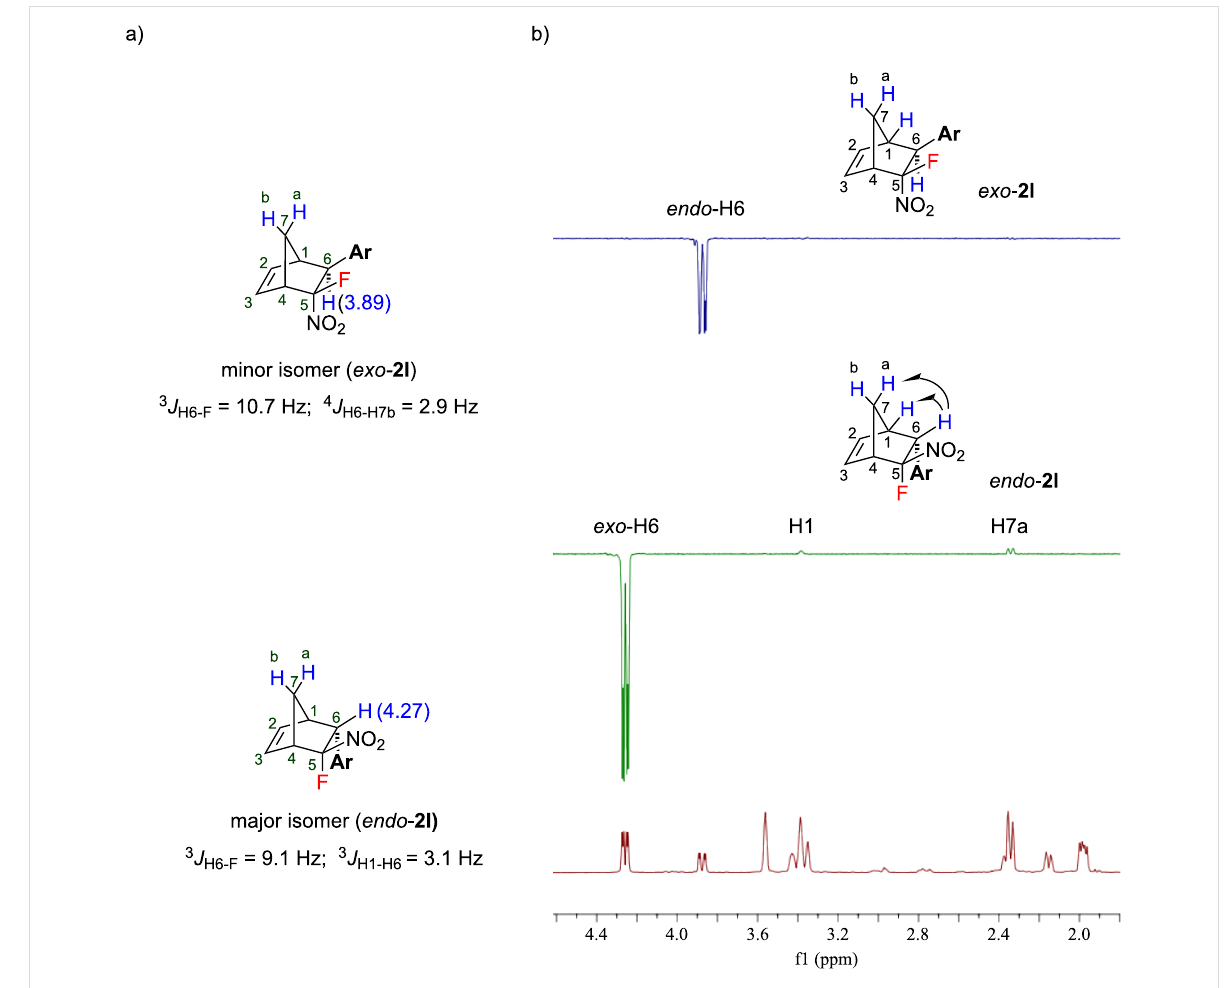
Figure 1: The structure assignment of norbornenes 2 by 1 H (a) and NOE (b) NMR spectroscopy.